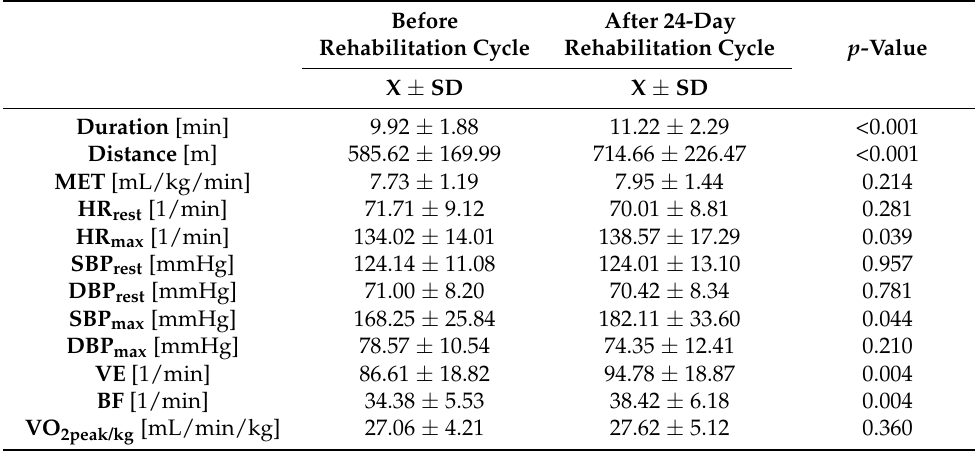
Table 4. Spiroergometric test